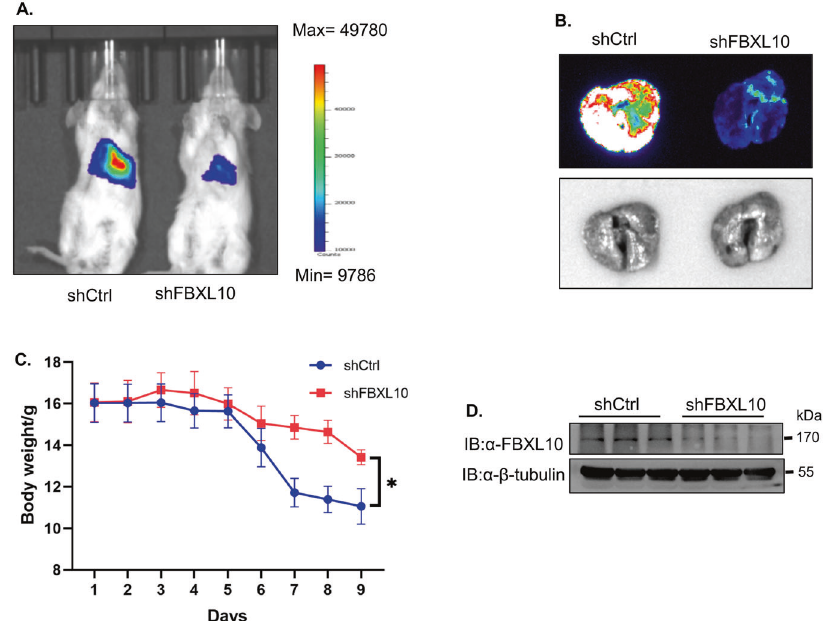
Fig. 7 FBXL10 enhanced the metastasis of breast cancer cells in mouse model. A Quantitative bioluminescence imaging showed the effect of shFBXL10 on the metastasis potential of 4T1-luc cells in BALB/C mice. B Bioluminescence imaging showed the relative metastasis potential of 4T1-luc cells in lung of BALB/C mice. C Line bar image showed the body weight of BALB/C mice injected with 4T1-luc cells stably transfected with shCtrl or shFBXL10. D Western blot showed the expression levels of FBXL10 in the 4T1-luc transfected with shCtrl or